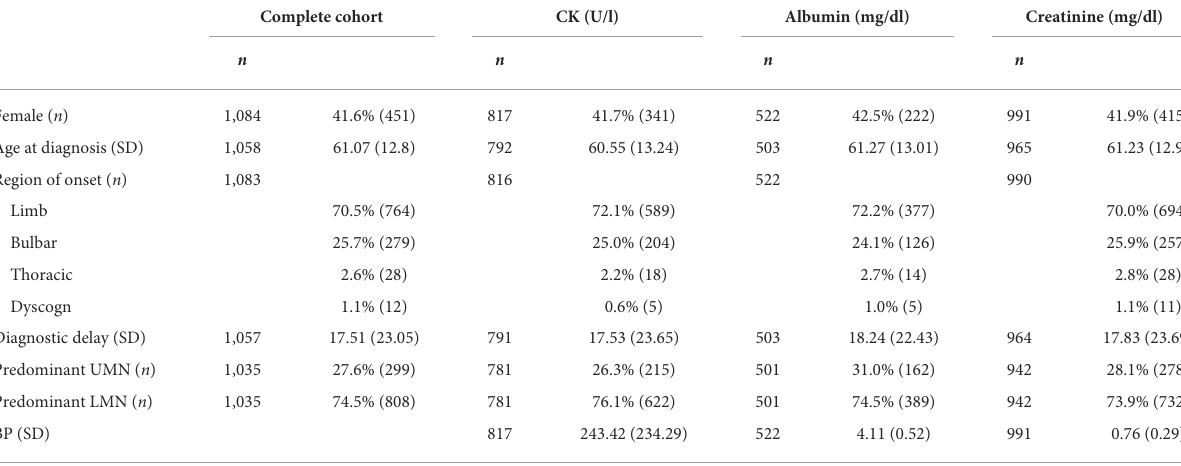
TABLE 1.1 Description of patient’s characteristics according to blood parameter-group.